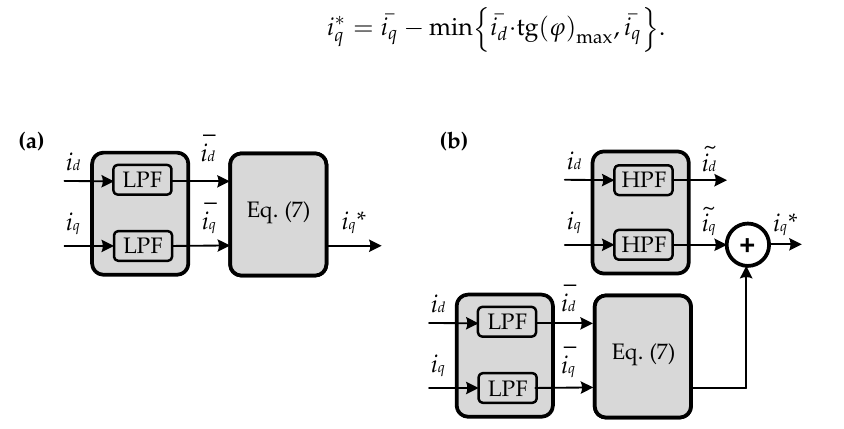
Figure 4. Possible filters for i d and i q component when the permissible value of tan ( φ ) is included. For the required functionality of the APF system: ( a ) only reactive power compensation and ( b ) higher harmonic elimination with reactive power compensation.